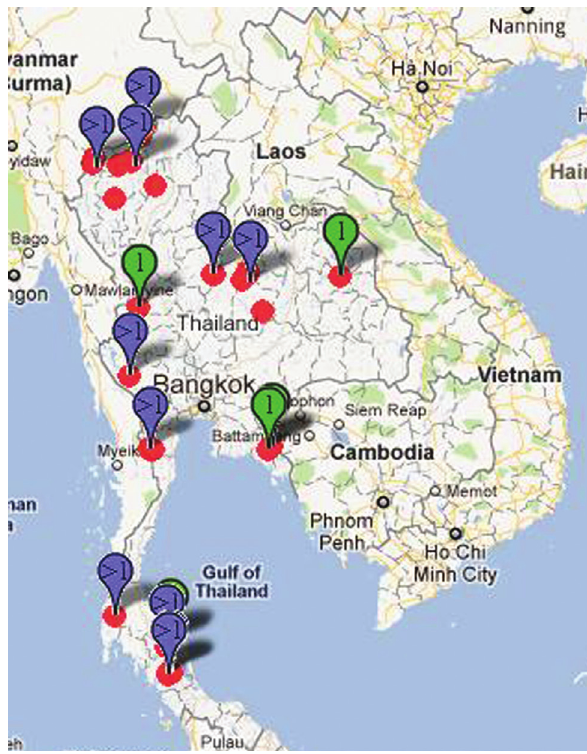
Figure 1. Map showing collection sites in